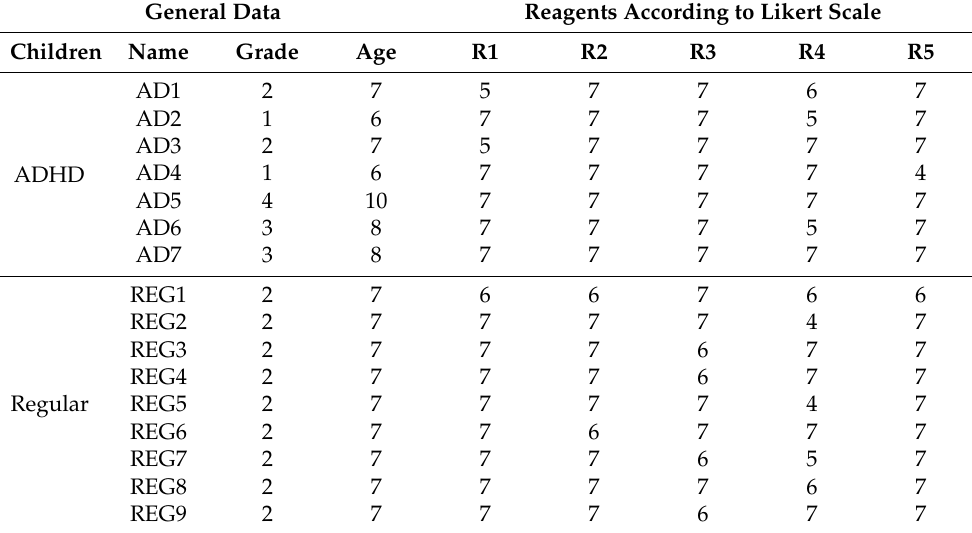
Table 6. Perception of use and satisfaction reagents from the assessment instrument applied to children who used